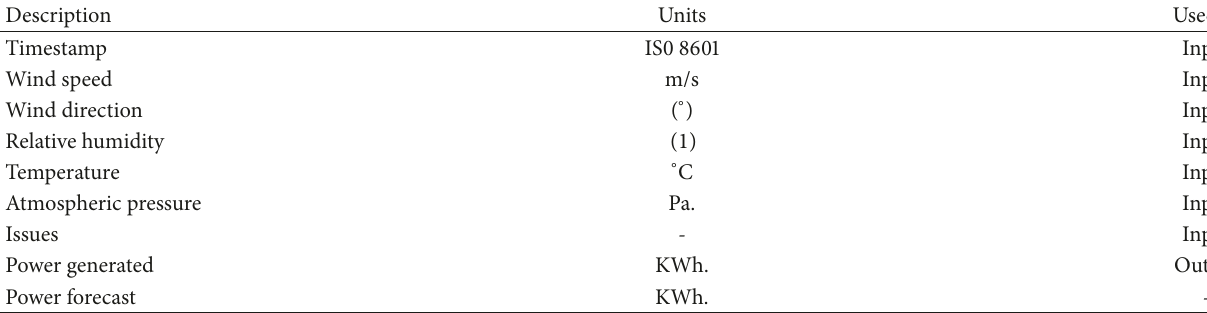
Table 2: Features in data